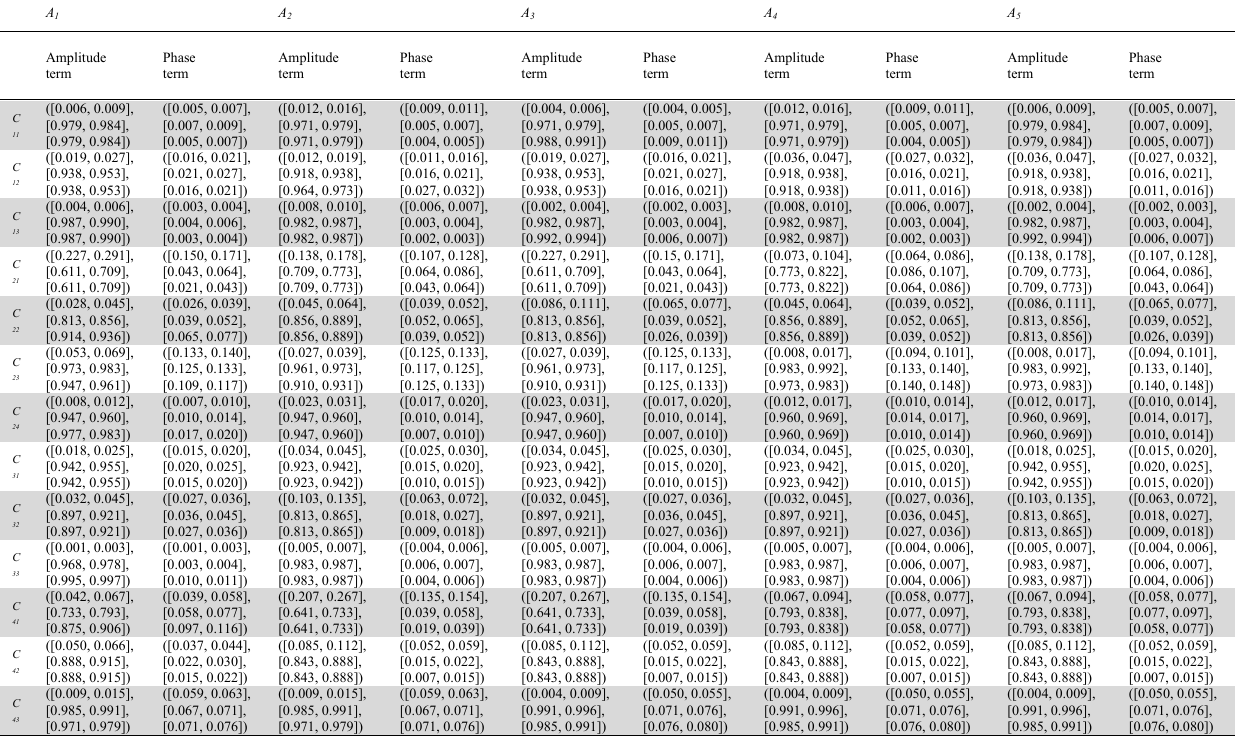
The positive and negative ideal solutions (PIS and NIS)